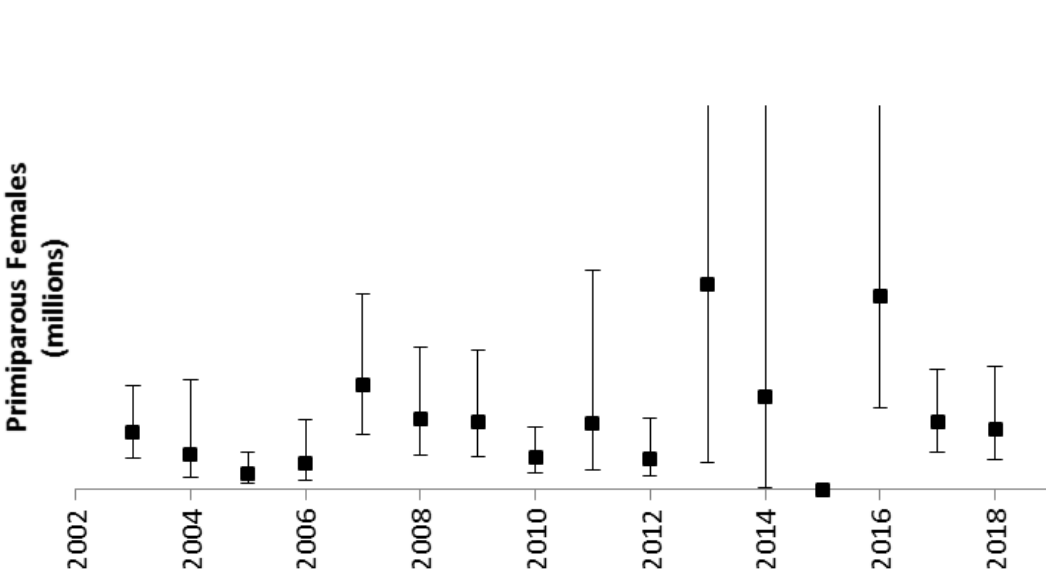
Figure 106. CMSA model estimated primiparous female abundance with lower and upper 95% confidence limits. Upper confidence limits for 2013, 2014, and 2016 extend beyond y-axis with values of CONFIDENTIAL. Y-axis values have been removed due to CONFIDENTIAL data.